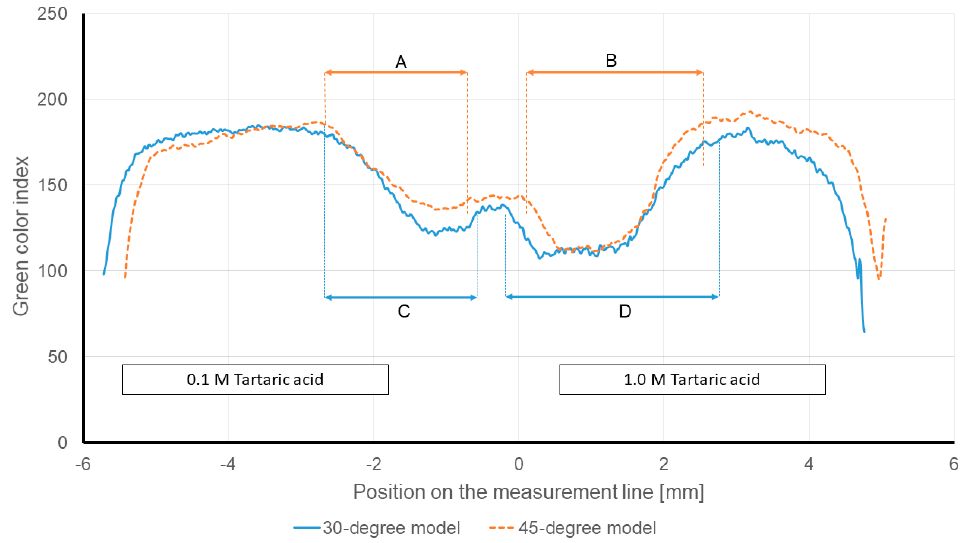
Figure 9. Intensity of the green color channel at the measurement line of different models at 240 s after the “Time zero”. In all the models, 0.1 and 1.0 M tartaric acid solutions were entered through the left and right inlets, respectively.